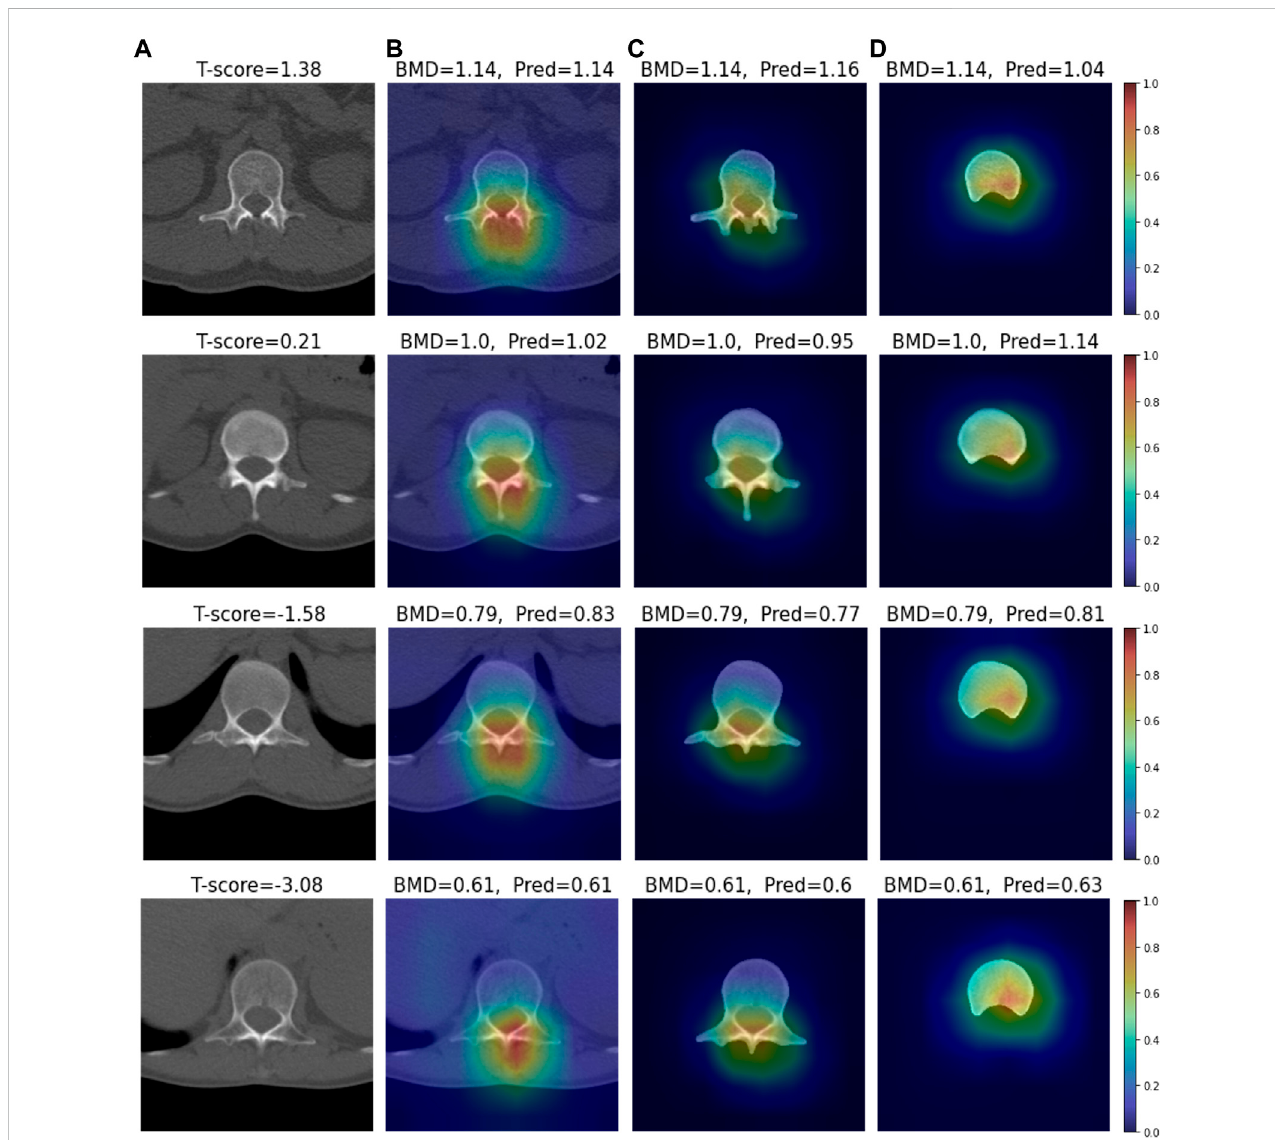
FIGURE 7 Visual XAI results (4 test samples) using Grad-RAM. The results of every sample are represented by every row. Every row, (A) represents the cropped CT image.AT-scorevalueisplacedatthetopofeveryimage. (B – D) displaytheheatmapsuperimposedonthecroppedimageorbone-segmentedimage. (B – D) show Grad-RAMP results in Case 1, Case 2 and Case 3, respectively. “ BMD ” and “ Pred ” placed at the top of every image denote the reference and predicted values,